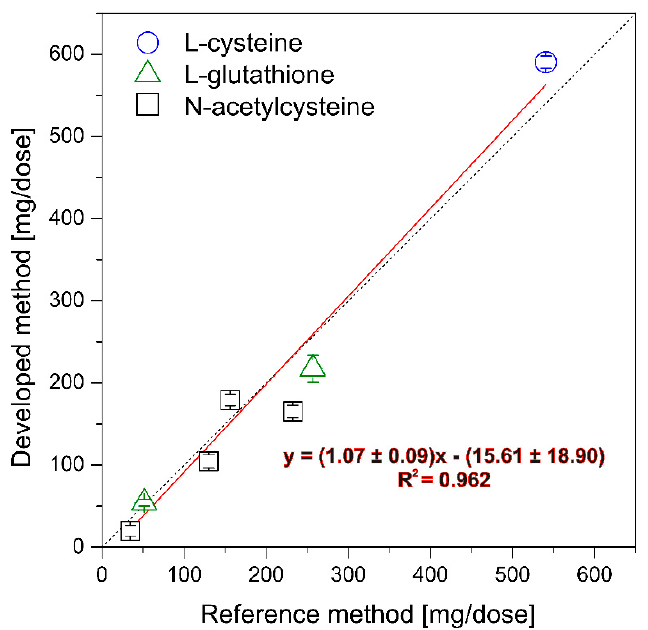
Figure 6. Correlation between the results obtained using the developed and reference method.